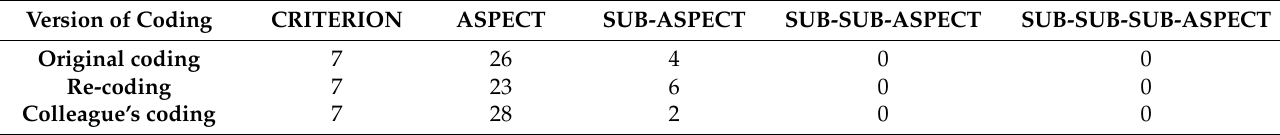
Table 2. Inter-rater reliability: Number of codes per classification of oral sub-skills into categories for ST Y906. Version of